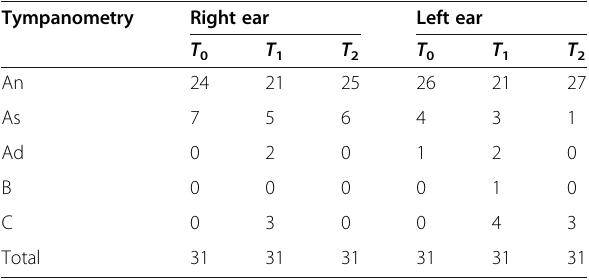
Table 3 The distribution of tympanometry diagrams during the time in the right and left ears Tympanometry